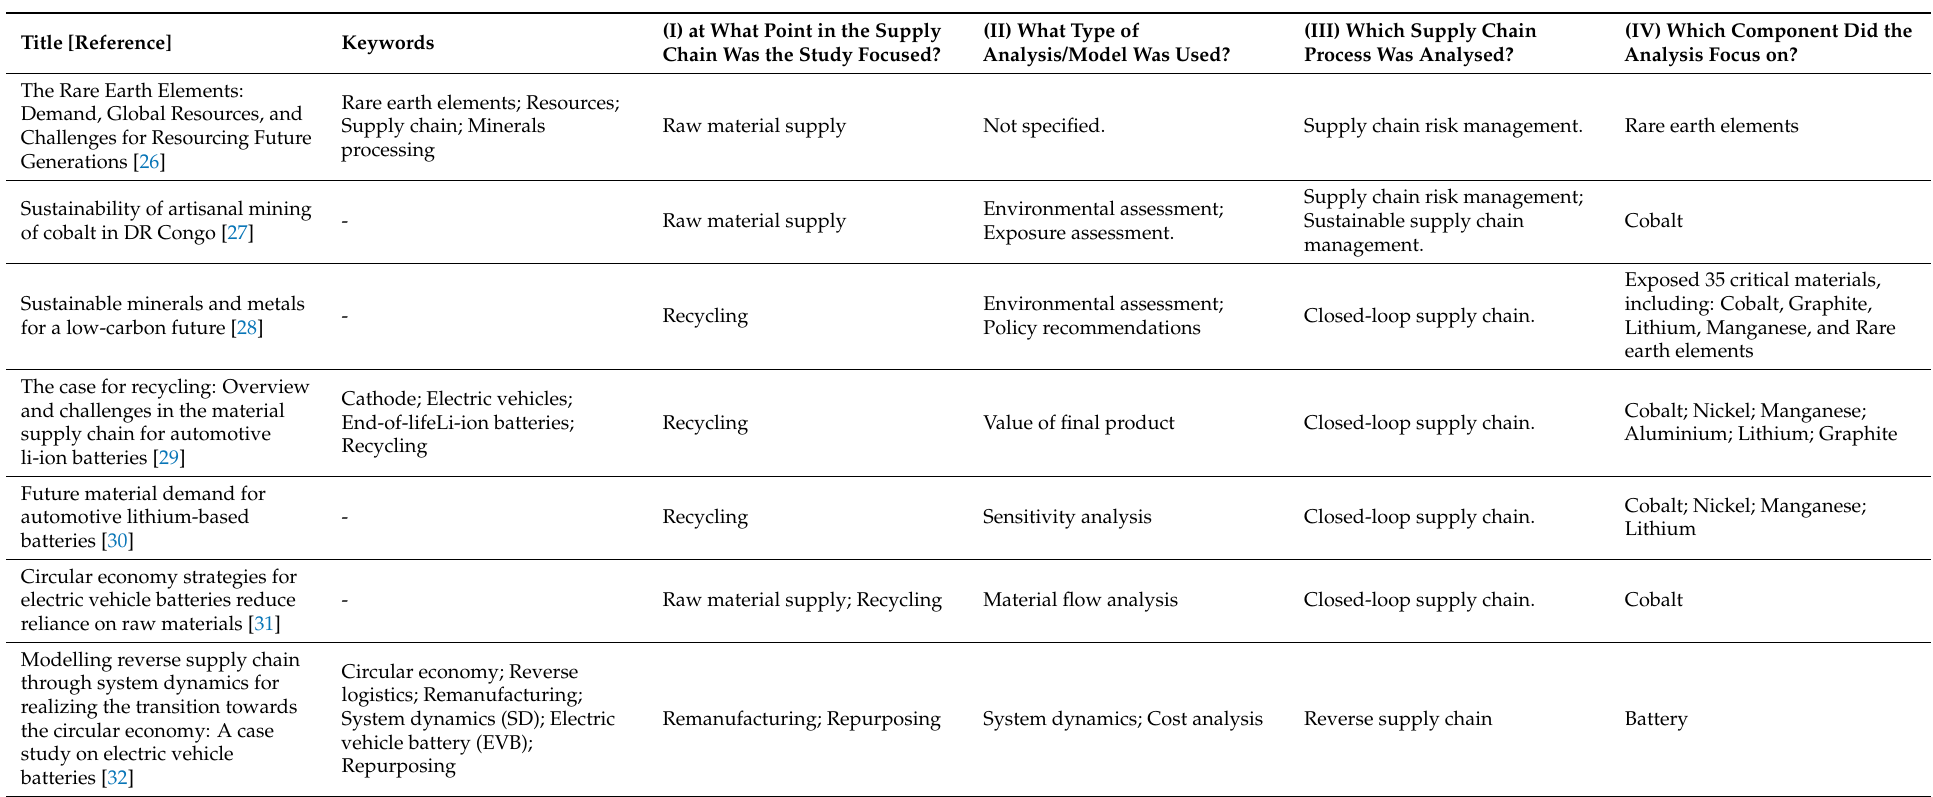
Table A1. PRISMA meta-analysis of documents found about the electric vehicles supply